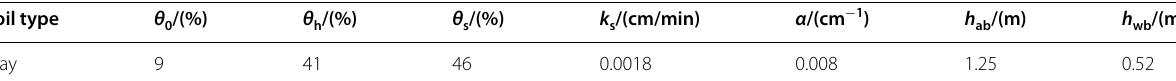
Table 1 Soil hydraulic parameters for the one-dimensional infiltration-runoff experiment Soil type